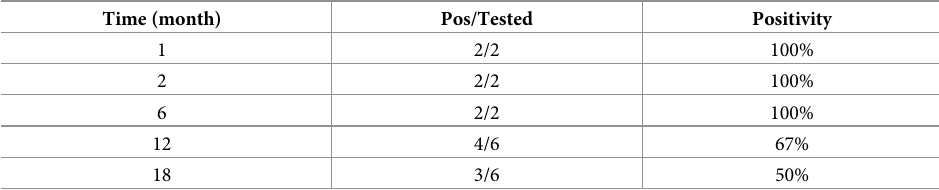
Table 2. Stability of FTA cards at room temperature for LAMP tests.